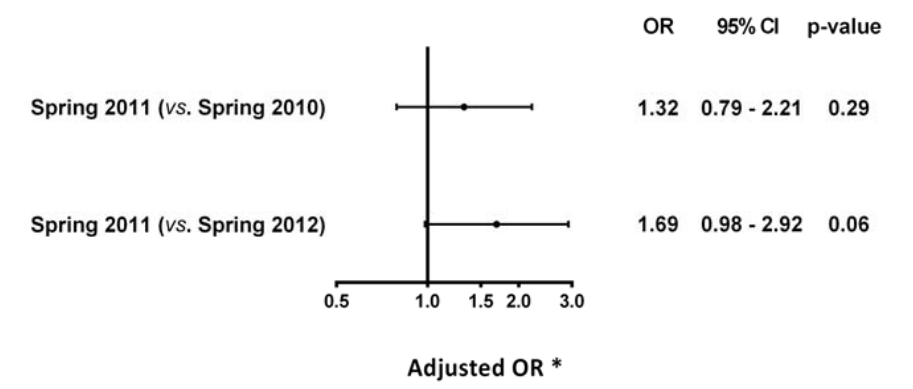
Figure 4. Risk of acute CVD among individuals with a medical history of CVD. * Adjusted for age, gender, Charlson comorbidity index, diabetes, hypertension, and mental health disorders. CI: confidence intervals, OR: odds ratio.